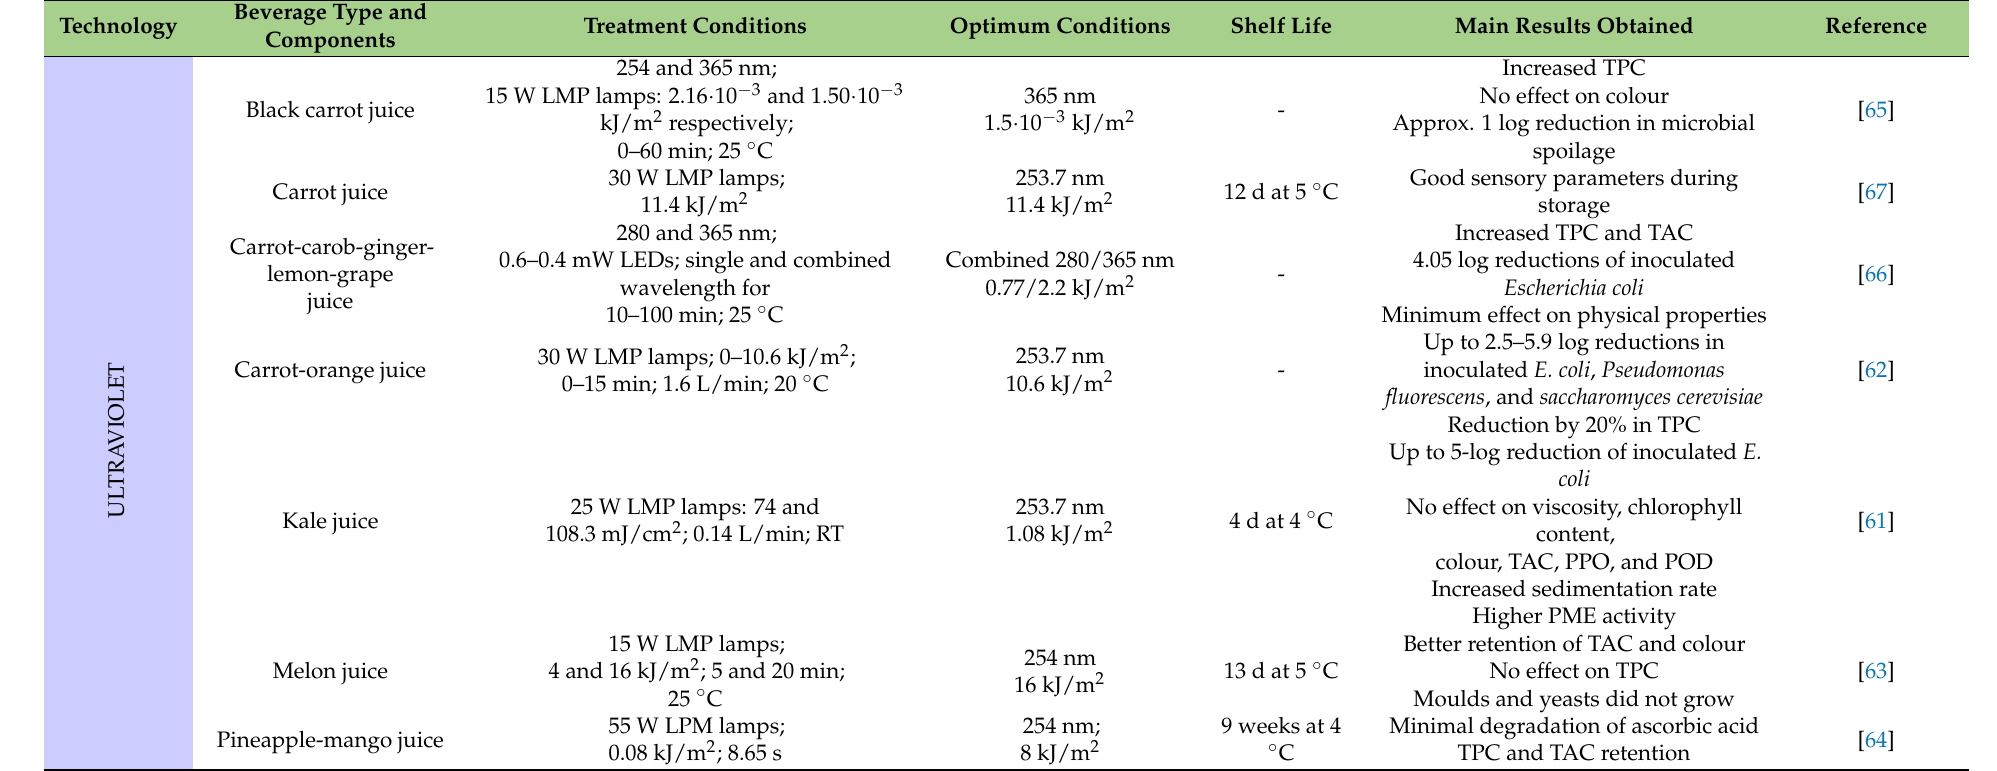
Table 1. Effects of green processing technologies on the phytochemical profiles of juice and smoothie beverages, along with other quality